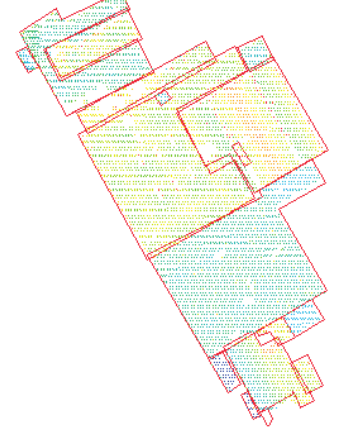
Figure 8. Superimpose the outlines of all planes on the building point cloud.